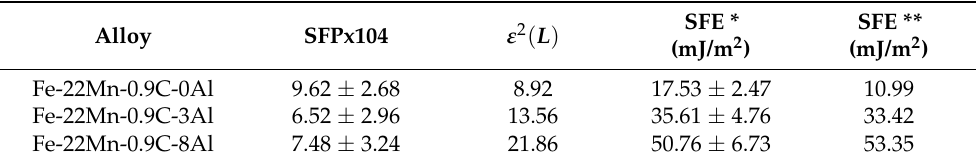
Table 5. List of parameters from diffraction peaks for each alloy used to calculate the SFE. Alloy